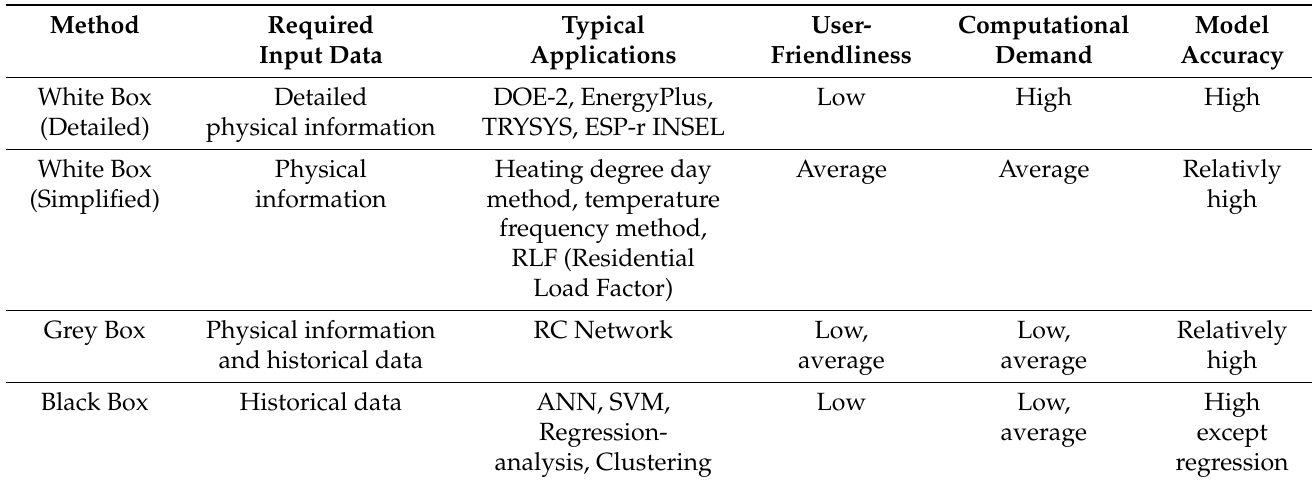
Table 1. Comparison of different building demand prediction methods. Own representation based on